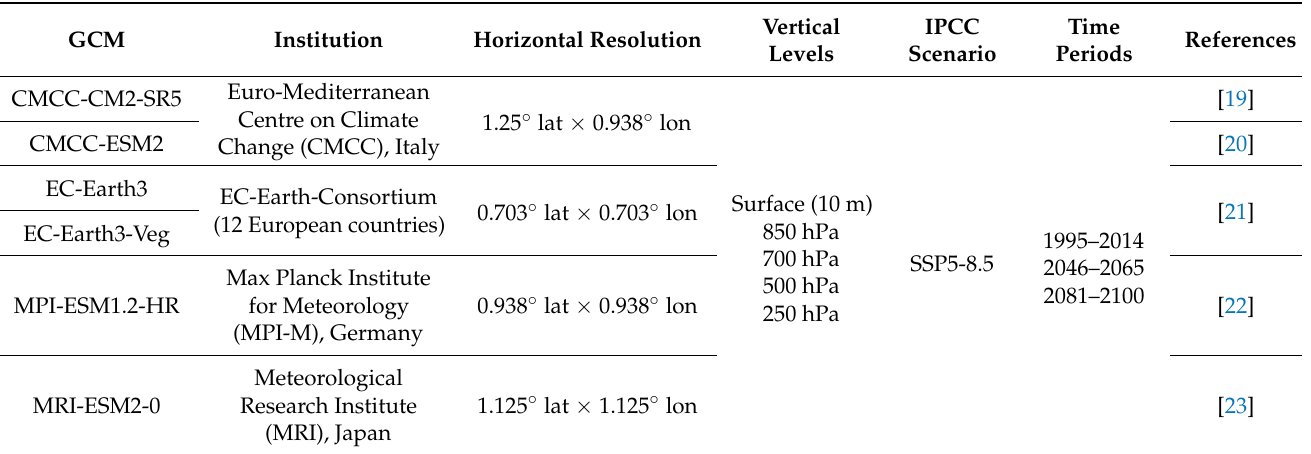
Table 1. CMIP6 GCMs: institution, horizontal and vertical resolutions, IPCC scenarios, time periods considered, and relevant references.